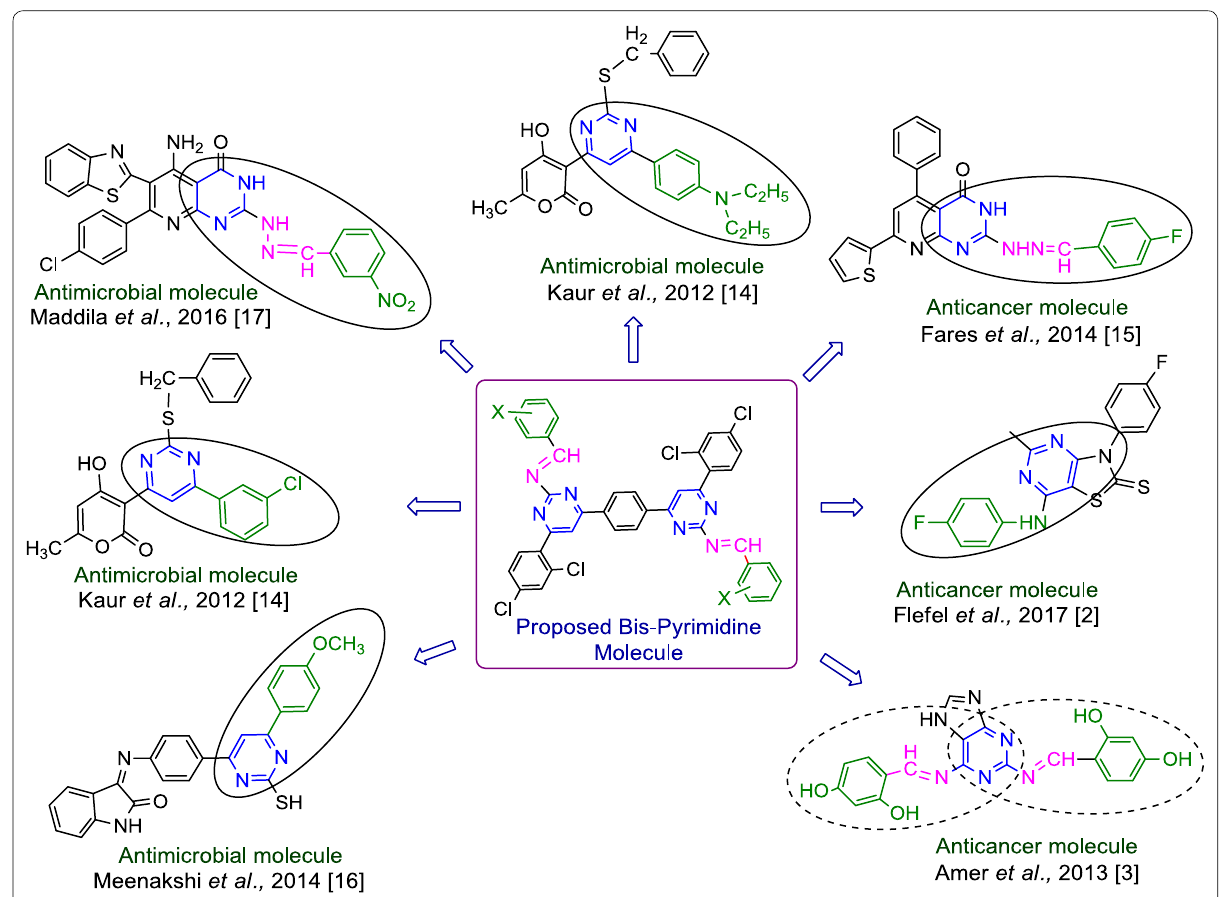
Fig. 1 Design of pyrimidine molecules for antimicrobial and anticancer potential based on